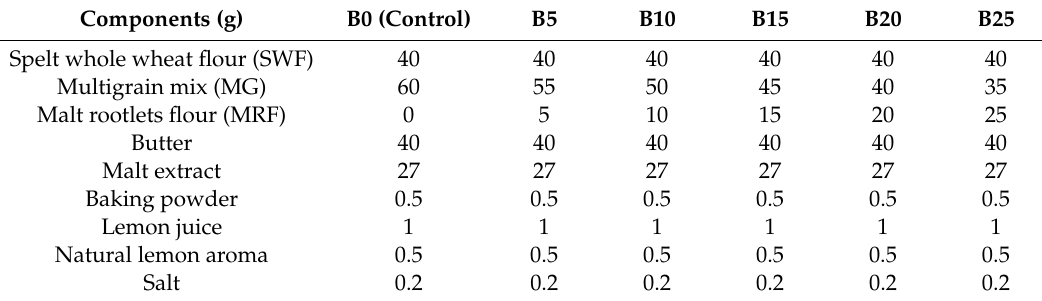
Table 6. Formulation used for the preparation of enriched